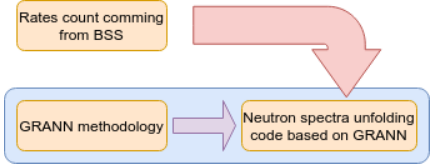
Figure 1. General view of the main stages for implementing the Synapse code